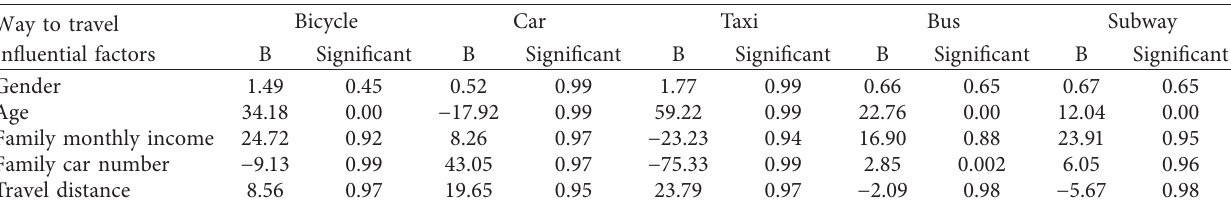
Table 3: Parameter estimation results.